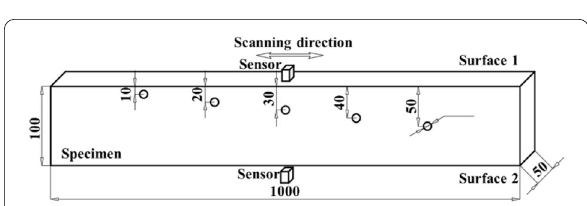
Figure 18. Five blind holes (Diameter: 2.0 mm; Depth: 20.0 mm) with the buried depth changing from 10.0 mm